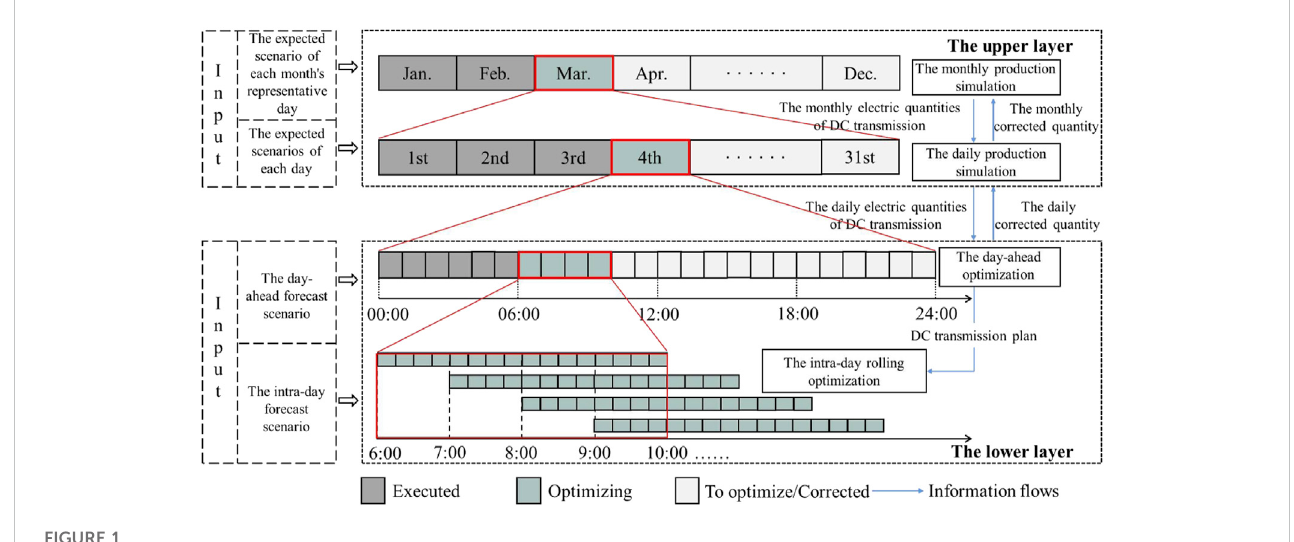
FIGURE 1 A two-layer framework for multi-time scale stochastic production